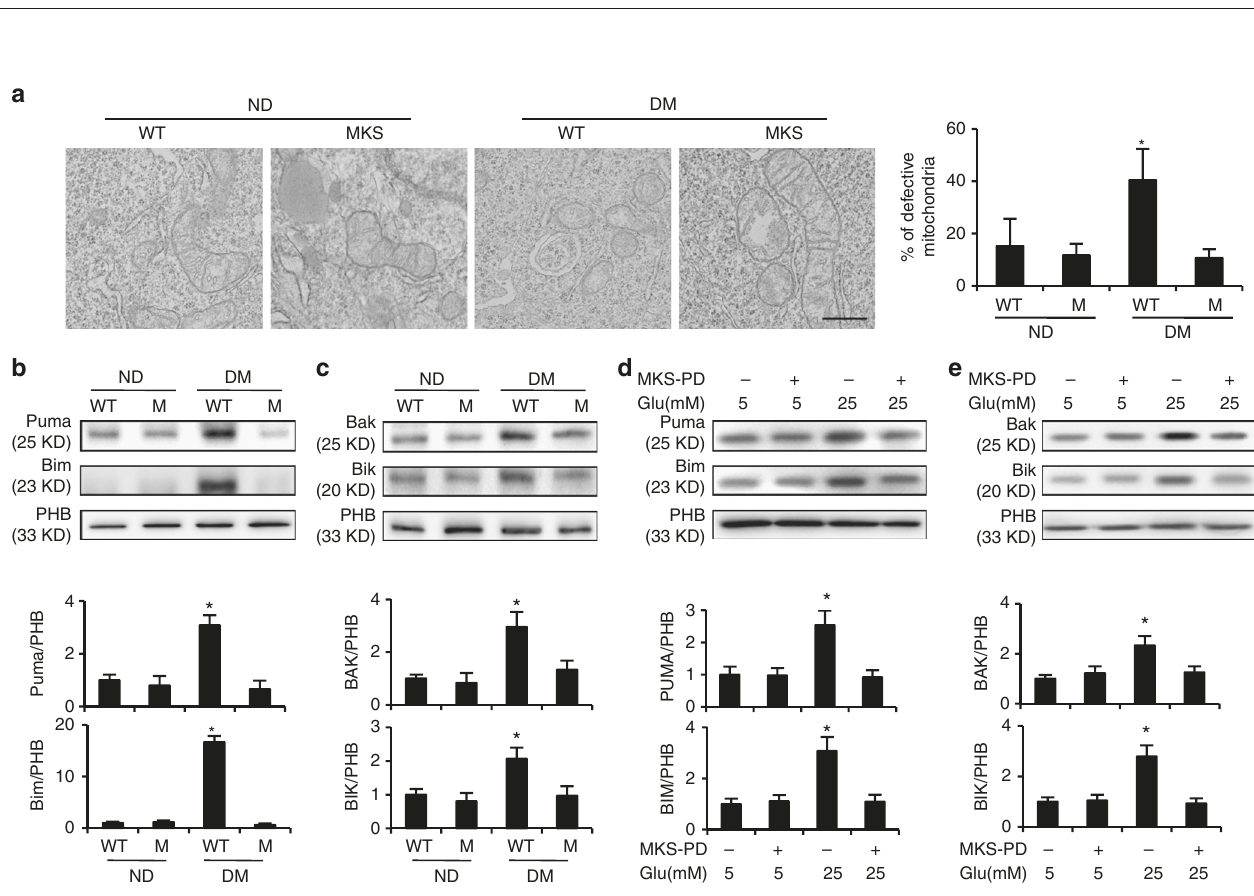
Fig. 2 Phosphorylated-MARCKS dissociation from mitochondrial membrane. Cytosol and mitochondrial MARCKS and p-MARCKS in E8.5 embryos ( a ) and cultured cells ( b ). Bar graphs were quanti fi cation data. M: MARCKS-PD; MKS: MARCKS; PHB: prohibitin. ( c ) Co-localization of MARCKS (green) with the mitochondrial membrane protein, Tom20 (red), in cultured cells. The bar graph was the quanti fi cation data of yellow density (co-localization). The region with white squire square in upper panel were ampli fi ed in lower panel. Bar in upper and lower panel indicates 17.5 μ M and 7.5 μ M respectively, d Co- localization of MARCKS (green) with the mitochondrial membrane protein, Tom20 (red), in the developing neuroepithelium of E8.75 embryos. The bar graph was the quanti fi cation data of yellow density (co-localization). Bar indicates 12.5 μ M. e Localization of phosphorylated MARCKS (green) in the cytoplasm of cultured cells. Mitochondria membrane (red) was labeled by transfection of a plasmid (DsRed2-Mito-7, Addgene, #55838). The bar graph was the quanti fi cation data of green density. Bar indicates 15 μ M. Co-localization of MARCKS and Tom20 was assessed by the proximity ligation assay (PLA) in the embryonic neuroepithelium ( f ) (Bar indicates 40 μ M) and cultured cells ( g ) (Bar indicates 15 μ M). Dot lines indicates neural tube. Red dots indicated that MARCKS interacted with Tom20. The bar graph was the quanti fi cation data of red PLA dots per cell. ND nondiabetic, DM diabetes mellitus, NG normal glucose (5 mM), HG high glucose (25 mM). All experiments were repeated three times. In A, three litters per group (one litter per run) were used. One way ANOVA with the Tukey test was used to analyze the data. * Indicates signi fi cant difference ( P < 0.05) compared to other